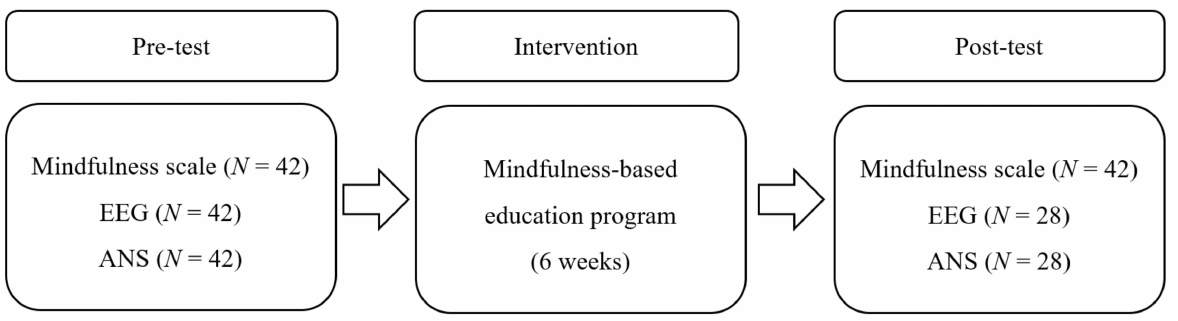
Figure 1. Research design 2.3. Data